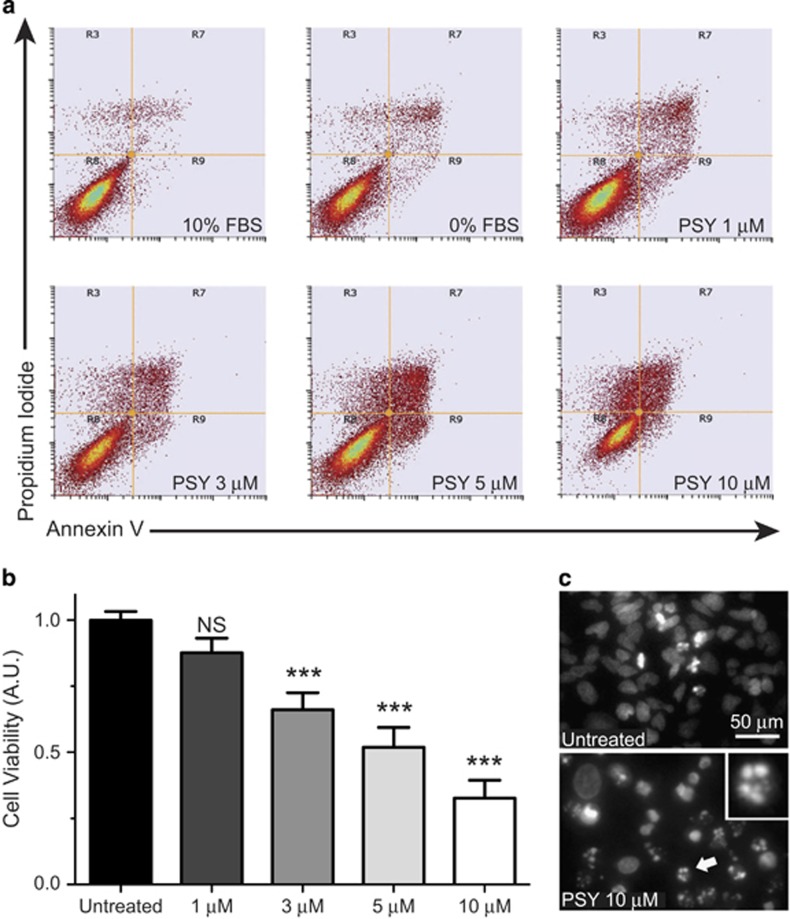
PSY induces dose-dependent cell death in MO3.13 cell line. (a) Representative dot-plots of MO3.13 cells stained with Annexin V/propidium iodide and analyzed by flow cytometry: R8, R9, R7 and R3 quadrants define the healthy, apoptotic, secondary necrotic and necrotic populations, respectively. (b) PSY dose–response quantification of cell viability (n=7, one-way ANOVA (Dunnett's post-hoc test ) PSY 1–10 μM versus Untreated). (c) Representative nuclear morphologies (imaged by Hoechst staining and fluorescence microscopy) for Untreated (top panel) and PSY-10-μM-treated (bottom panel) cells. The bottom panel inset shows a zoomed image of the nucleus indicated by the white arrow. The presence of condensed/fragmented nuclei is a typical feature of apoptosis induction